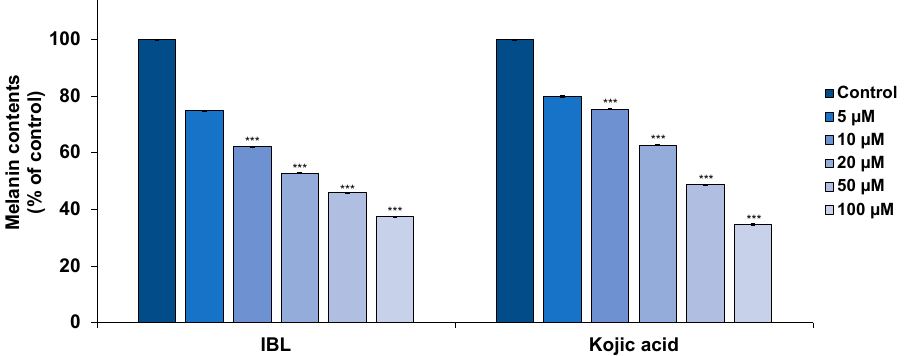
Figure 3. Effect of IBL on melanin content in B16F10 cells. B16F10 cells were stimulated with 100 µM IBMX for 24 h after pretreatment with the indicated concentrations of IBL (5–100 µM) or kojic acid (5–100 µM) for 48 h. The melanin content was measured at 405 nm using a microplate reader. Values are represented as means ± SEM. ( n = 3, *** p ≤ 0.001).